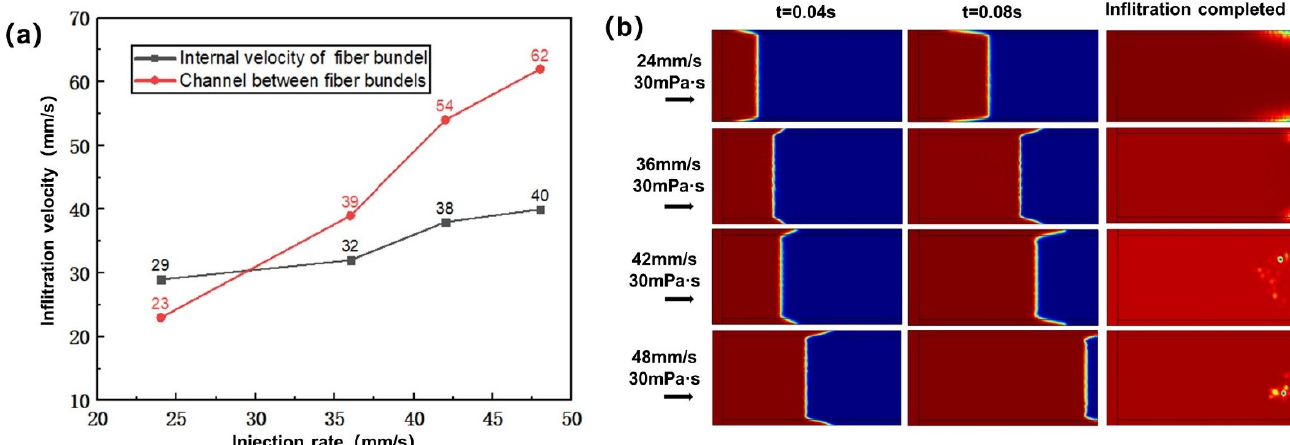
Figure 8. ( a ) Influence of injection rate on infiltration flow velocity. ( b ) Influence of injection rate on infiltration flow front.